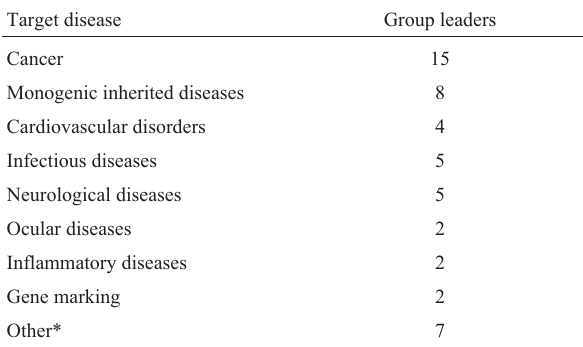
Table 1 - Target Diseases of Gene Therapy/DNA vaccine